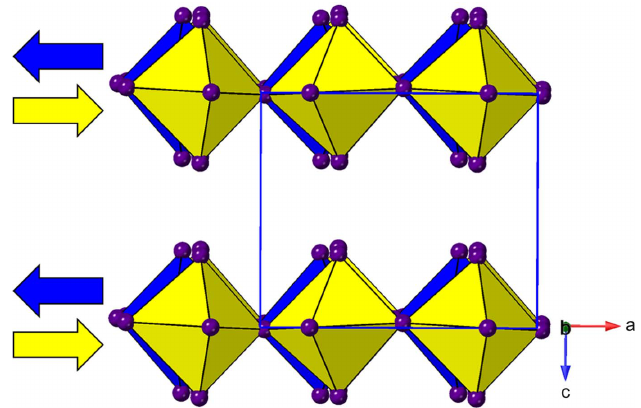
Figure 12 [C 6 H 16 N 2 ]PbI 4 (1816279) viewed along the c axis highlighting the fully ‘eclipsed’ DJ arrangement with an antiferrodistortive shift of the octahedra in the layer